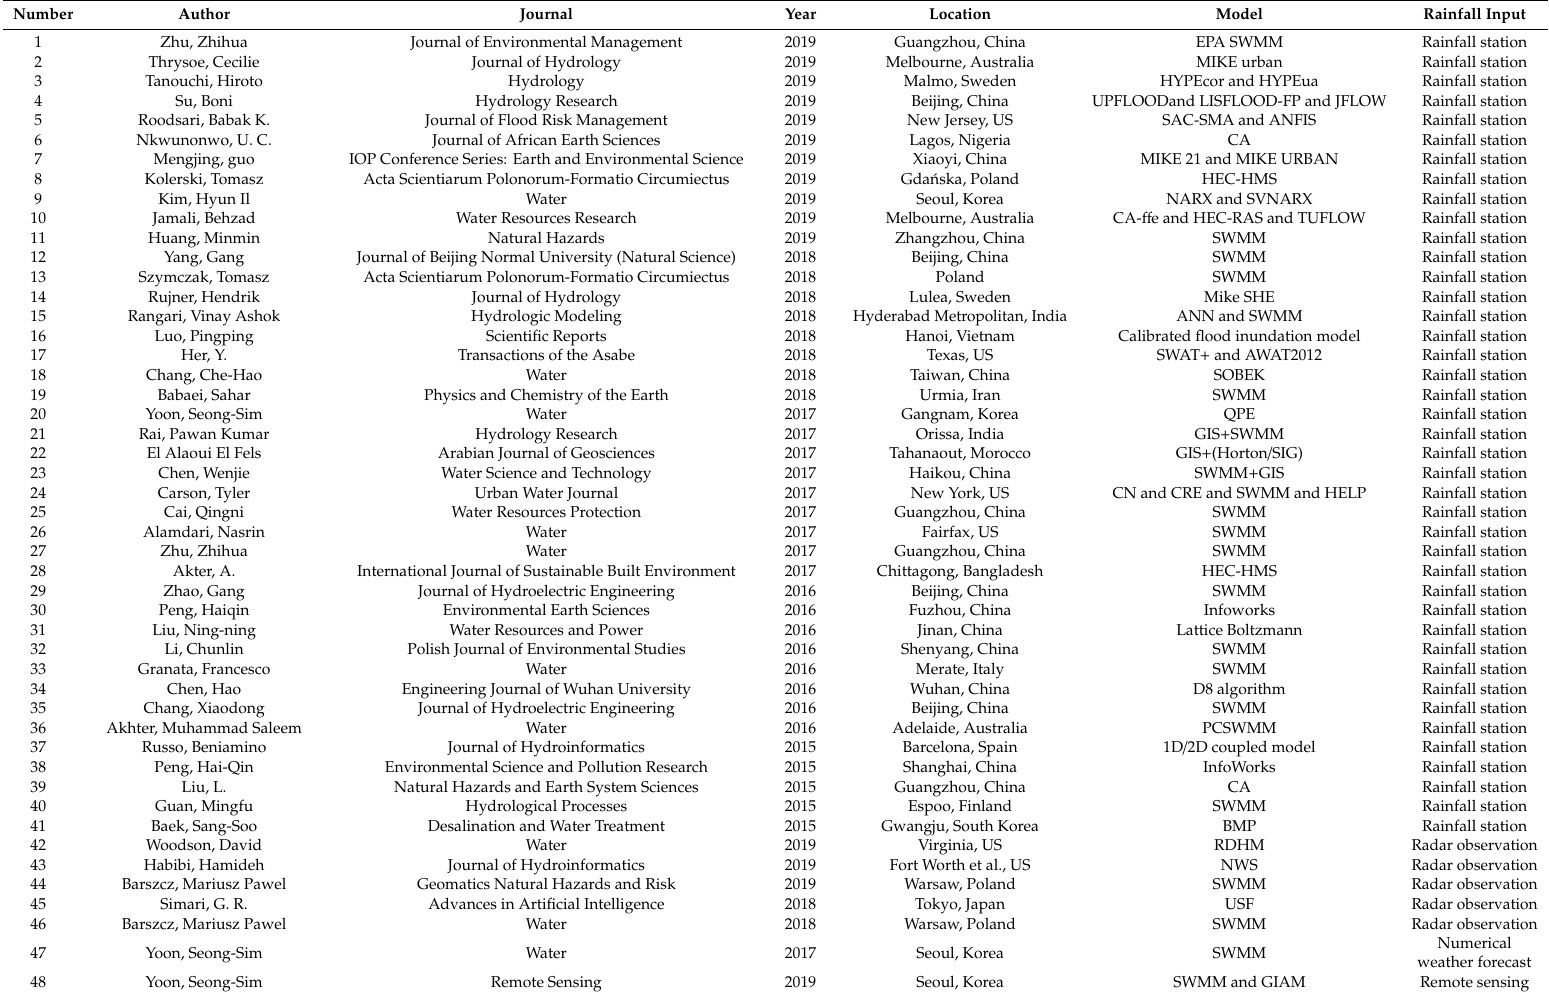
Table 1. Information of 48 peer-published